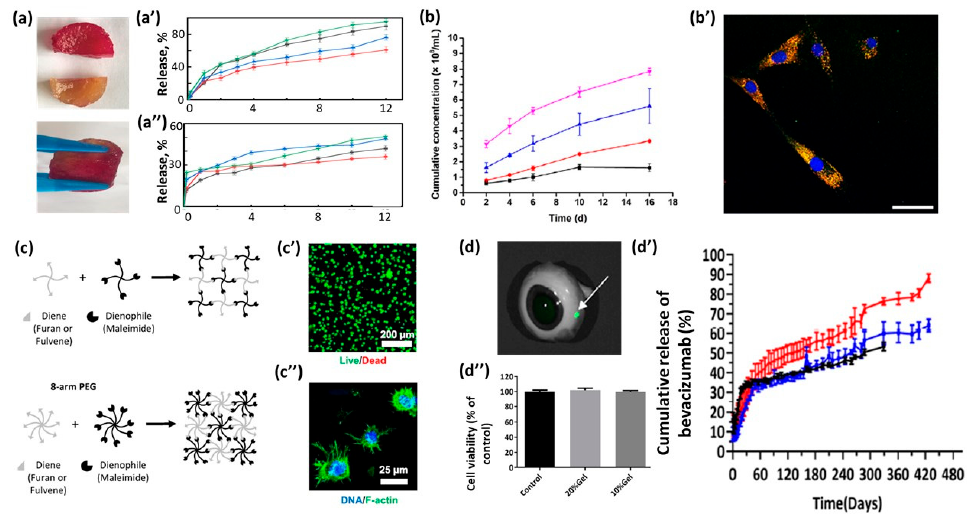
Figure 4. Application of DA-based hydrogels. ( a ) Self-healing property of sample hydrogel, top—cut hydrogel, and bottom—hydrogel healed for 5 h at 37 ◦ C. ( a’ , a” ). Cumulative release ratio of 5-fluorouracil from hydrogels with different diene/dienophile ratios under different simulated mediums: ( a’ ) pH = 7.4, ( a” ) pH = 1.2; reproduced from ref. [12]. Copyright 2021, Elsevier Ltd. ( b ) Total iMSC-sEVs release ratio from the hydrogel after 16 days. Black line—no hyaluronidase; red line—0.1 µ g/mL hyaluronidase; blue line—1 µ g/mL hyaluronidase; and pink line—10 µ g/mL hyaluronidase. ( b’ ) Chondrocyte uptake of DiI (lipid membrane dye) and SYTO (RNA-specific dye) RNAselect-labeled iMSC-sEVs released from the hydrogel. The scale bar is 50 µ m; reproduced from ref. [27]. Copyright 2021, Elsevier BV. ( c ) The 4-arm (top) and 8-arm (bottom) PEG hydrogels are prepared by mixing diene- (furan or fulvene) modified PEG with maleimide-modified PEG; ( c’ ) viability of hMSCs encapsulated in DA hydrogel gels after 7 days, measured by a live/dead cytotoxicity assay; ( c” ) confocal fluorescence micrograph showing the spread of hMSCs cultured in DA hydrogels for 7 days. The actin cytoskeleton was stained with phalloidin (green), and the nuclei were stained with Hoechst (blue); reproduced with permission from ref. [15]. Copyright 2019, American Chemical Society. ( d ) Fluorescent image of a porcine eye 5 min after intravitreal injection of 4-arm PEG DA hydrogel at 37 ◦ C (hydrogel marked by arrow); ( d’ ) QMMUC-1 cell viability in the presence of hydrogel leachables from 10 and 20 wt% 4-arm PEG hydrogels after 24 h incubation; ( d” ) cumulative release of bevacizumab from 4-arm PEG DA hydrogel. Red, blue, and black lines correspond to 25, 20, and 10 wt% concentrations of hydrogels, respectively; reproduced from ref. [29]. Copyright 2022, American Chemical